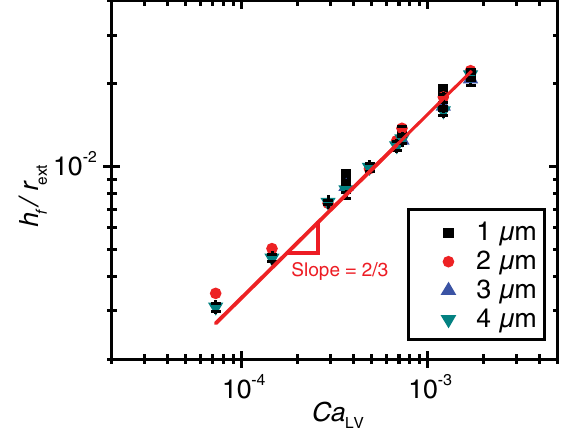
=r with Ca for various initial f ext LV